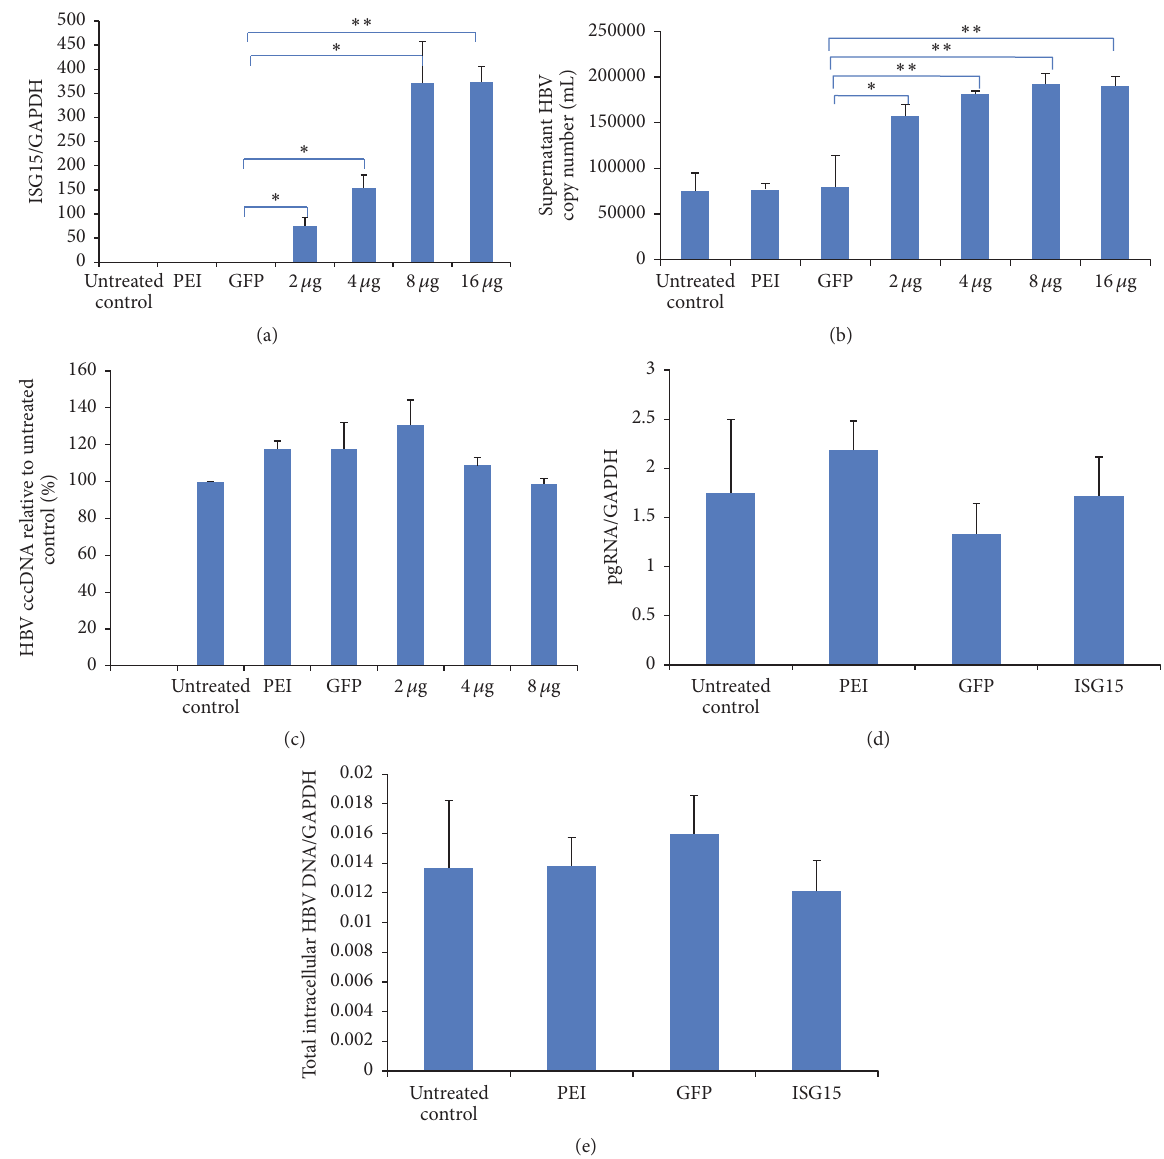
Figure 2: ISG15 overexpression promotes HBV production in vitro . HepG2.2.15 cells were transfected with the indicated amount of ISG15 plasmid or GFP-expressing plasmid. (a) Real-time PCR showing ISG15 mRNA expression 24h after transfection of ISG15 plasmid. GFP, transfected with 4 𝜇 g GFP-expressing plasmid; 2 𝜇 g, 4 𝜇 g, 8 𝜇 g, or 16 𝜇 g transfected with 2 𝜇 g, 4 𝜇 g, 8 𝜇 g, or 16 𝜇 g ISG15 plasmid. (b) Supernatant HBV DNA, intracellular, (c) cccDNA, (d) pgRNA, and (e) total HBV DNA were determined by real-time PCR 48 h after transfection, respectively. PEI, transfection regent polyethyleneimine (PEI) treatment only; GFP, transfected with 4 𝜇 g GFP-expressing plasmid; ISG15, transfected with 4 𝜇 g ISG15 plasmid. The results are presented as the means ± SD, 𝑛 ≥ 3 ; error bars indicate SD. ∗ 𝑃 < 0.05 ; ∗∗ 𝑃 < 0.01